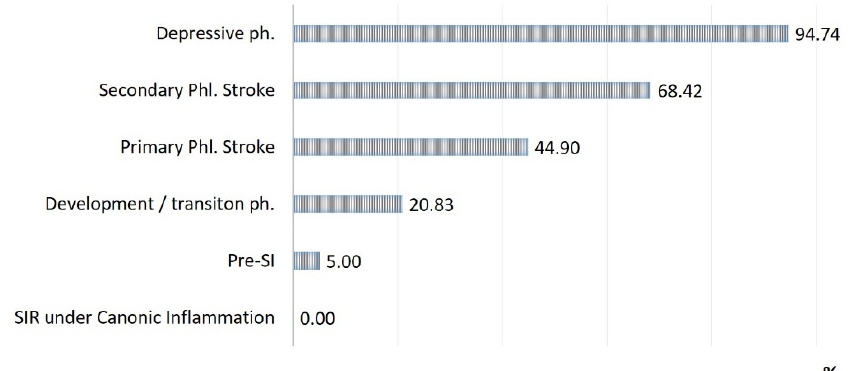
Figure 2. Distribution of patients in the study groups by type of inflammation and phases of SI (n = 233).